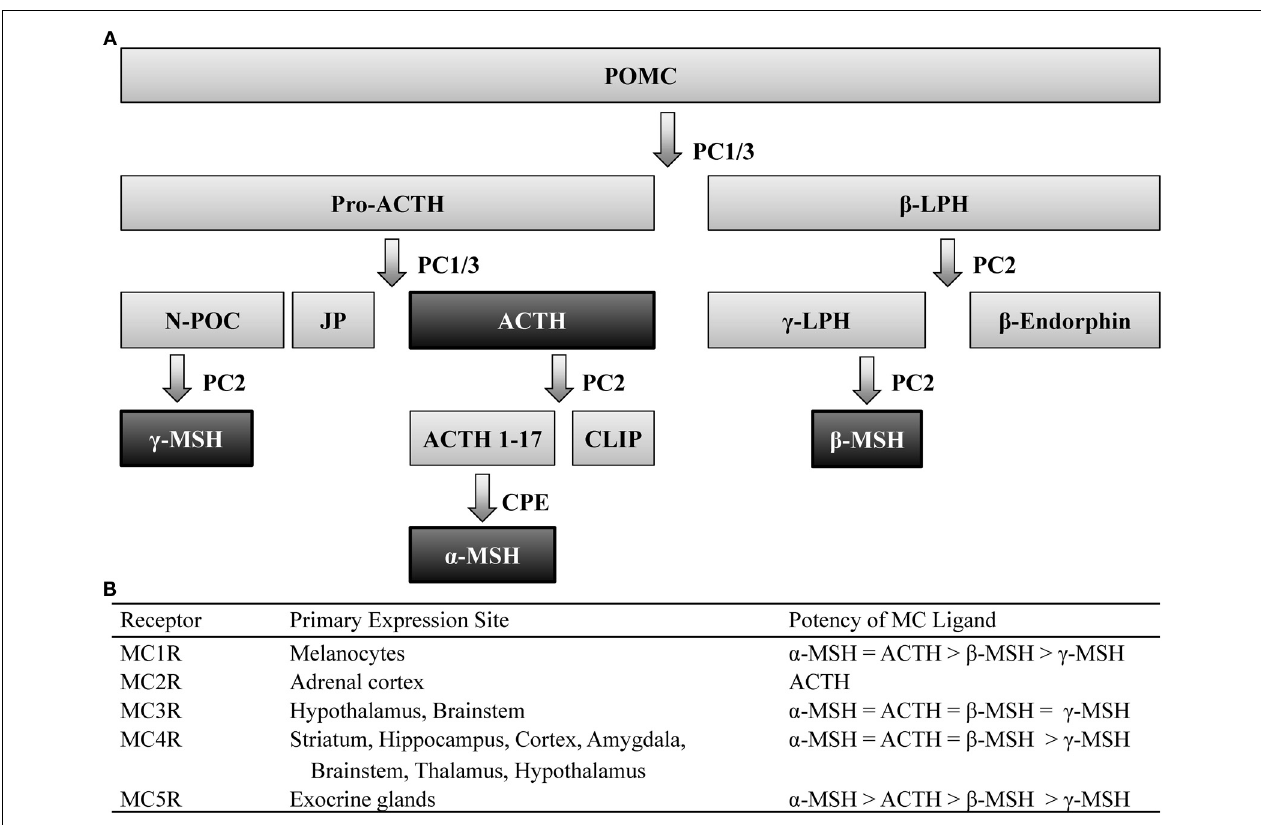
FIGURE 1 | Melanocortin ligands and receptors. (A) Simplified model of posttranslational processing of POMC. Agonists that act at MCR1-5 are highlighted black. (B) These ligands exert their effects via five G-protein coupled receptors, differentially expressed throughout the body, with varying degrees of potency. ACTH,